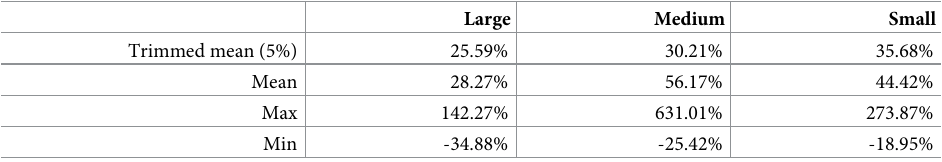
Table 5. Combined growth rates for large, medium and small FOSS organizations